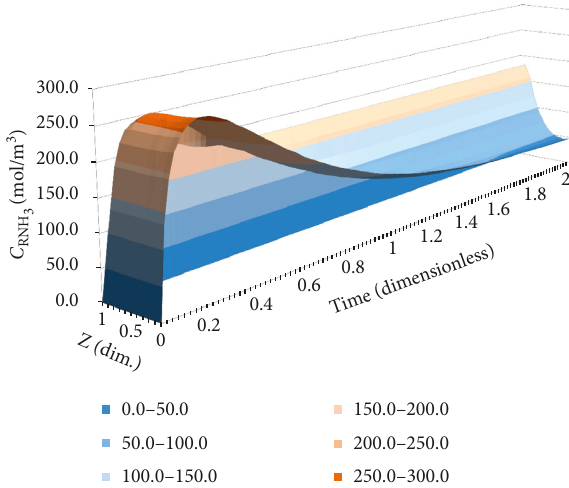
Figure 5: Time variation of the RNH